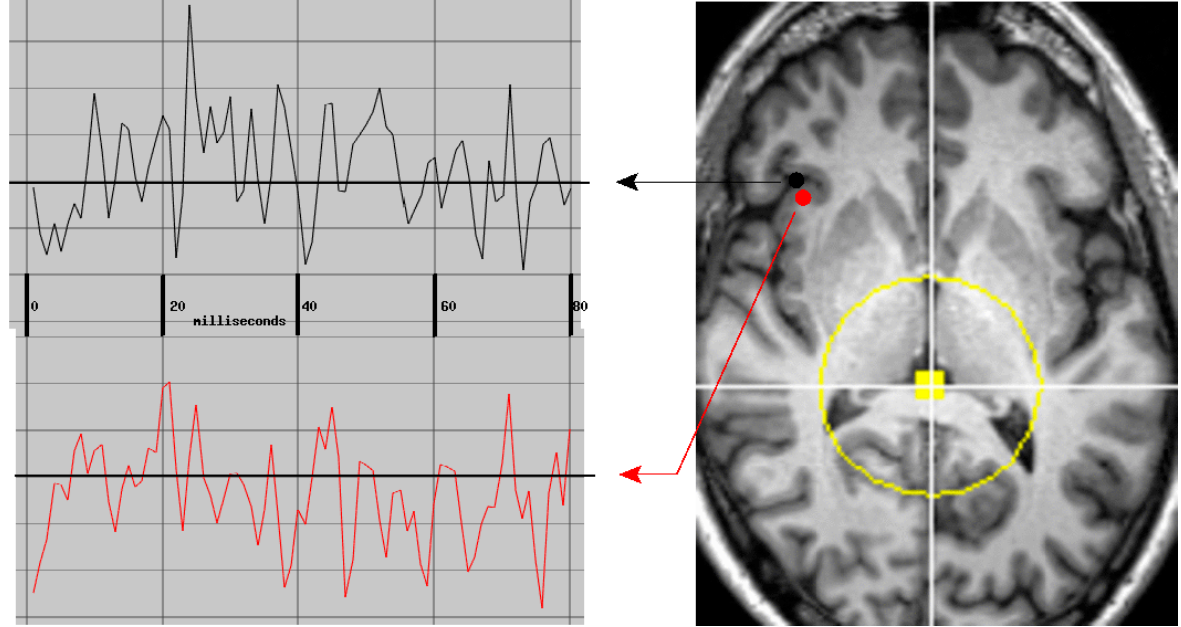
Figure 8. Two typical simultaneously active neuroelectric currents were identified and validated by the referee consensus solver, p < 10 − 12 for each—i.e., p < 10 − 4 for each when corrected for multiple comparisons. Each waveform has a duration of 80 msec sampled at 1000 Hz. The bandpass is 10–250 Hz. The currents are 5 mm apart with zero-lag cross-correlation of 0.157, df = 80, p = 0.16. The yellow dot and circle delineate the region near the center of the head which is excluded from the search for neuroelectric currents. See text for details.